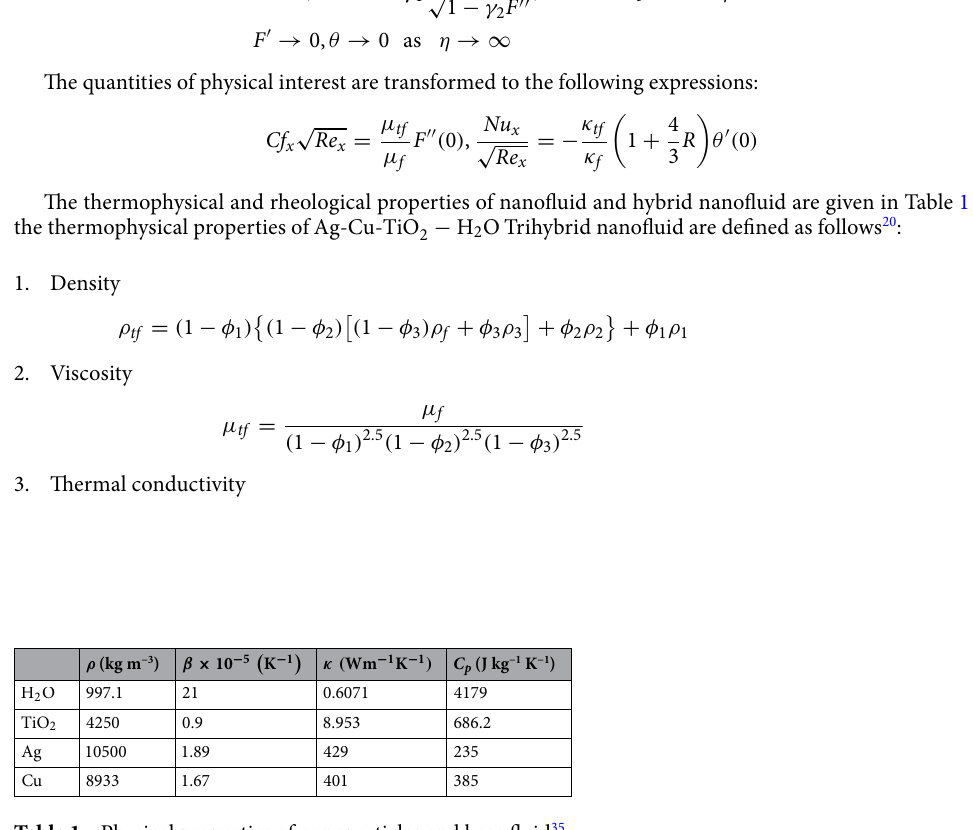
Table 1. Physical properties of nanoparticles and base fluid 35